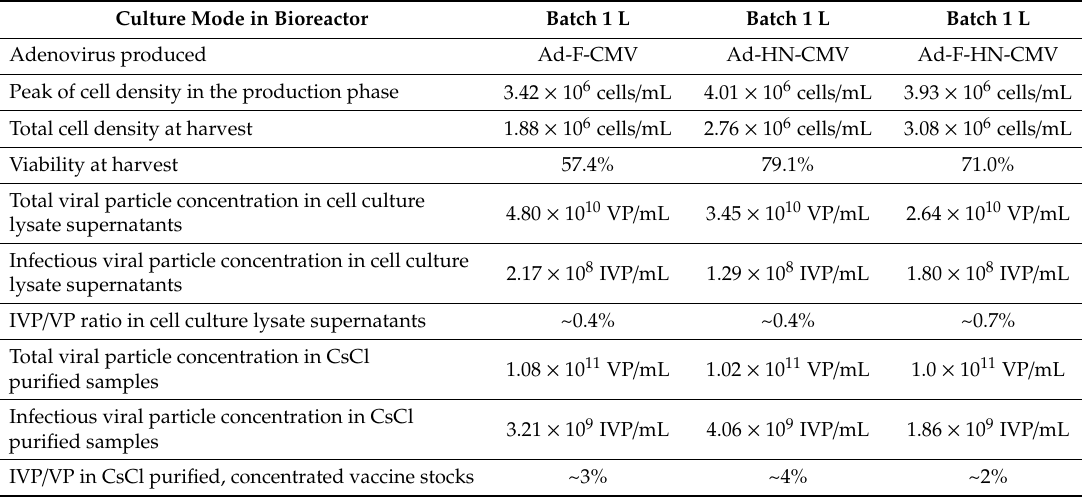
Table 1. Summary of key process data and recombinant adenovirus productivity in the 1 L bioreactors operated under batch culture